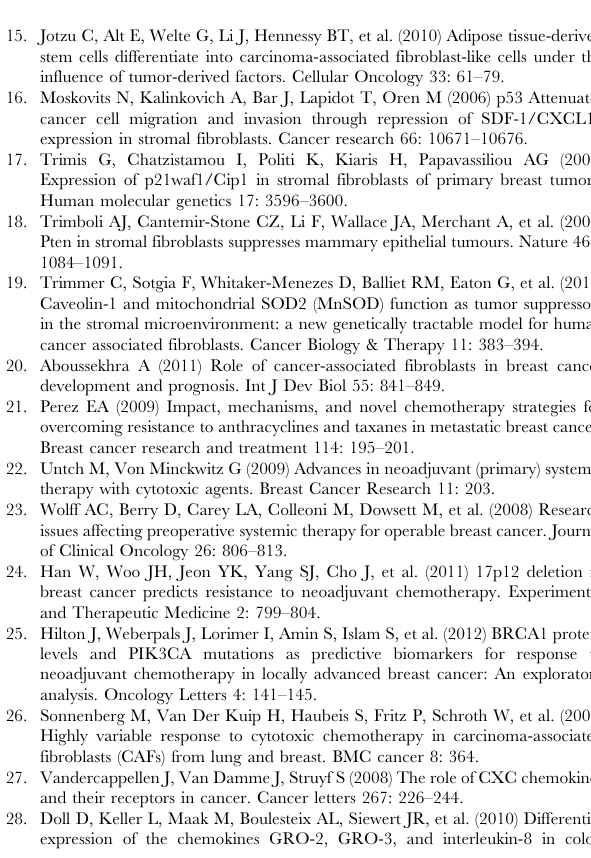
Table S1 The differentially expressed genes in CAFs after vs. before